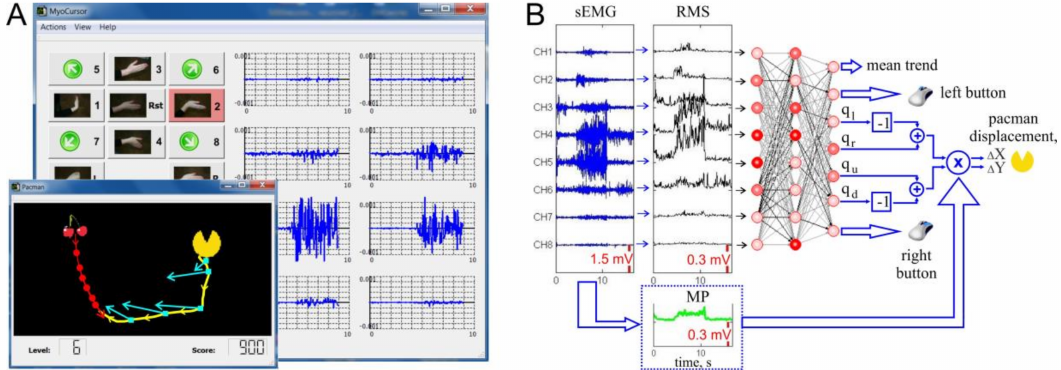
Figure 1. Software design of the sEMG-interface. ( A ) Main window of MyoCursor software (on background) and game window (foreground). A user controls by hand gestures “pacman” (yellow icon) and aims at reaching “cherries” (shown in red), which also can move. In the main window, the current gesture “go left” (G 2 ) is shadowed by red. Blue traces show sEMG patterns recorded from eight electrodes of the Myo bracelet. ( B ) Sketch of calculation of the pacman movement by an artificial neural network. Raw sEMG (blue traces) are used to evaluate RMS signals (black traces, Equation (1)). At the same time the mean power (MP) is calculated (green trace, Equation (3)). The artificial neural network classifies RMS patterns and yields an output for controlling the movement direction ( q l , q r , q u , q d ) . The “left–right” and “up–down” differences are multiplied by the MP to get proportional control ( ( ∆ X , ∆ Y ) in Equation